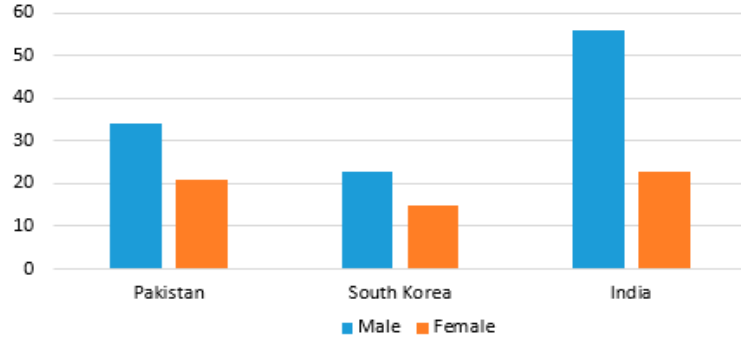
Figure 11. Gender distribution of participants in the traditional RE process.